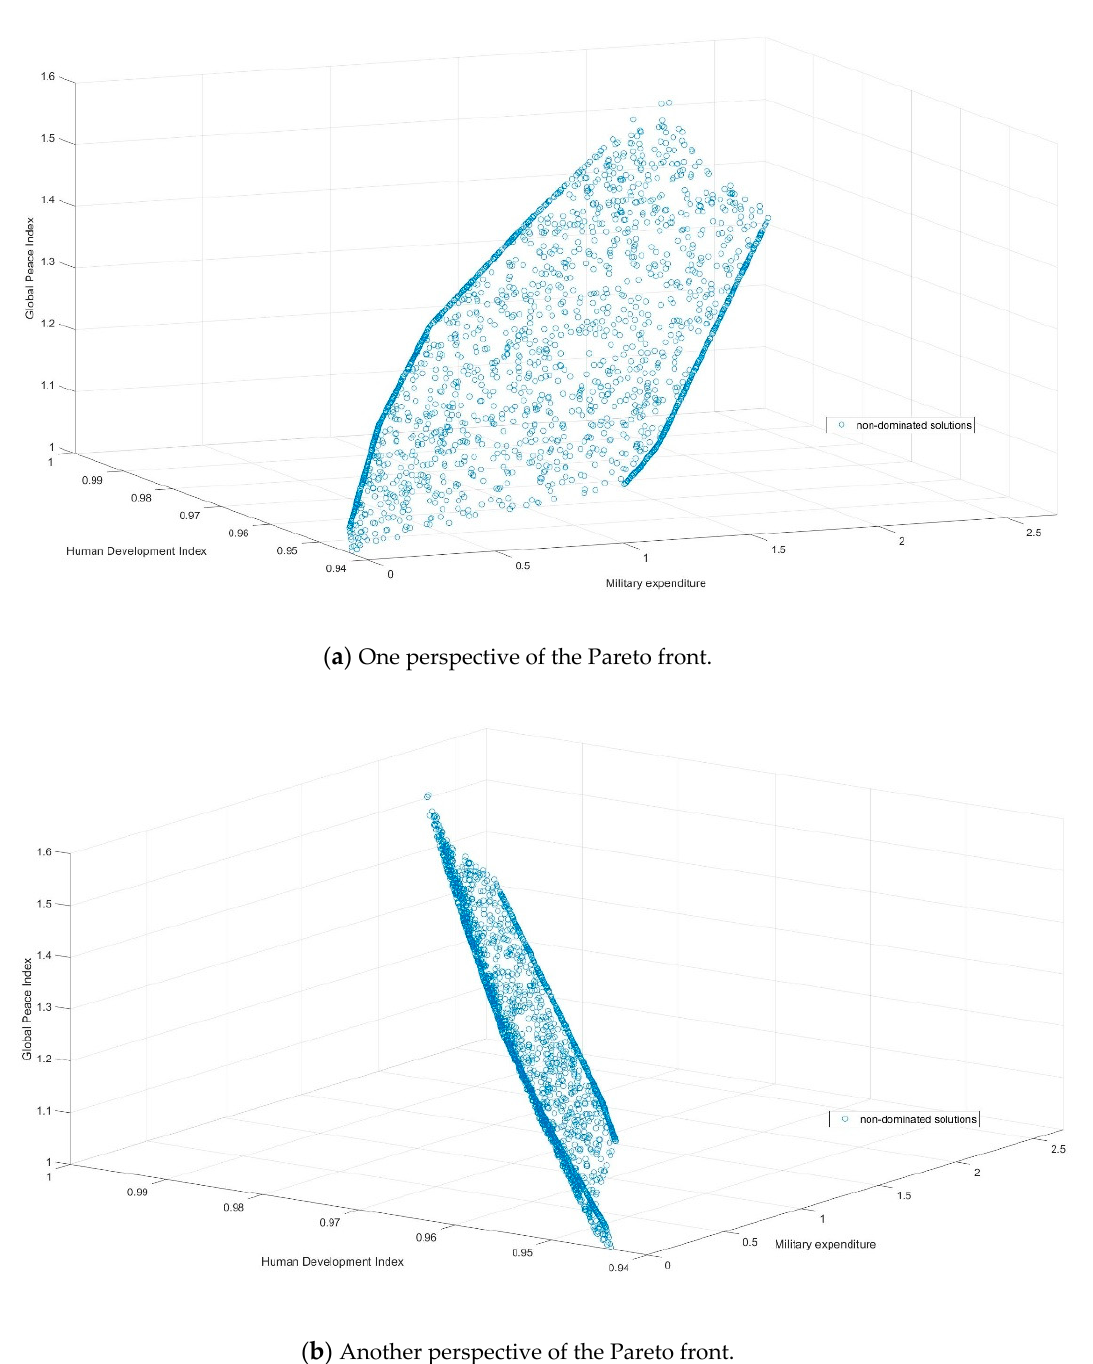
Figure 1. Pareto front generated considering the objectives for MEs, the HDI, and the GPI for the NATO countries included in this study.